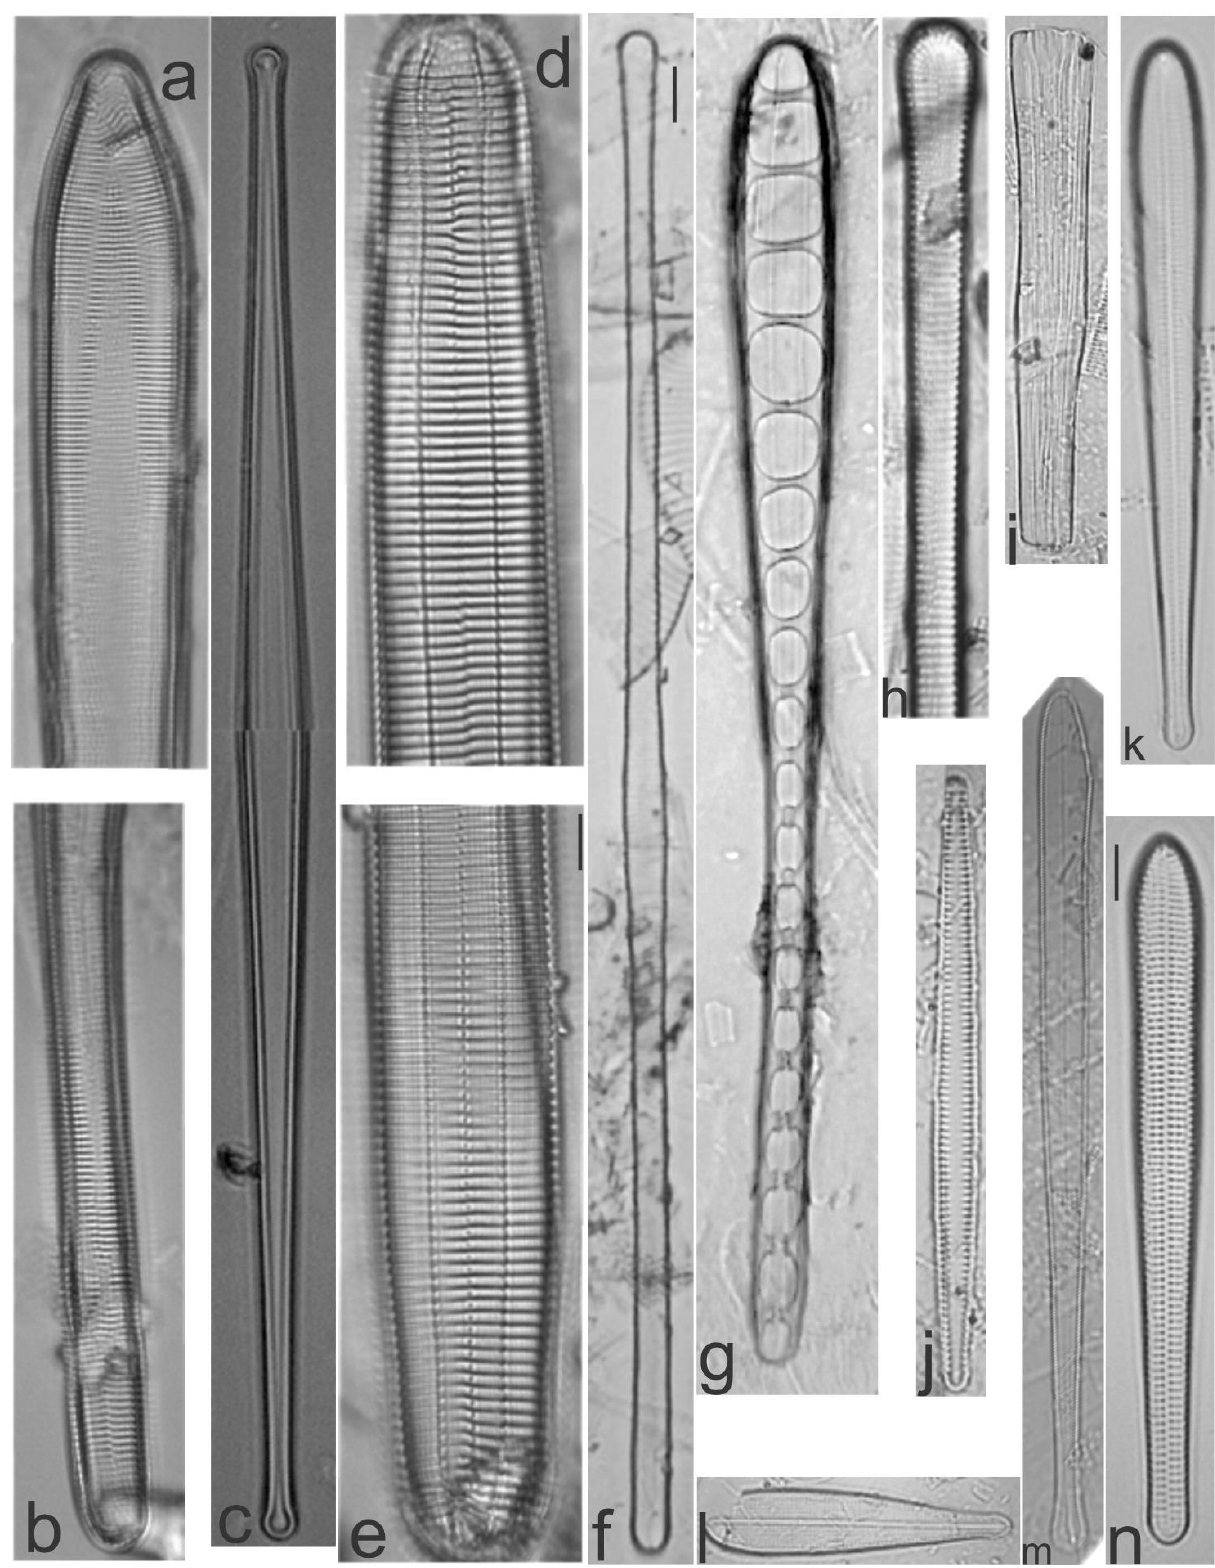
Figure 9. ( a , b ) Synedrosphenia cuneata ; ( c ) Hyalosynedra laevigata ; ( d , e ) Ardissonea robusta ; ( f , h ) Ardissonea crystallina ; ( g ) Climacosphenia moniligera ; ( i ) Neosynedra tortuosa ; ( j ) Tabularia fasciculata ; ( k ) Licmophora debilis ; ( l ) L. gracilis ; ( m ) L. flabellata ; ( n ) L. paradoxa . Scale bars = 5 μm.